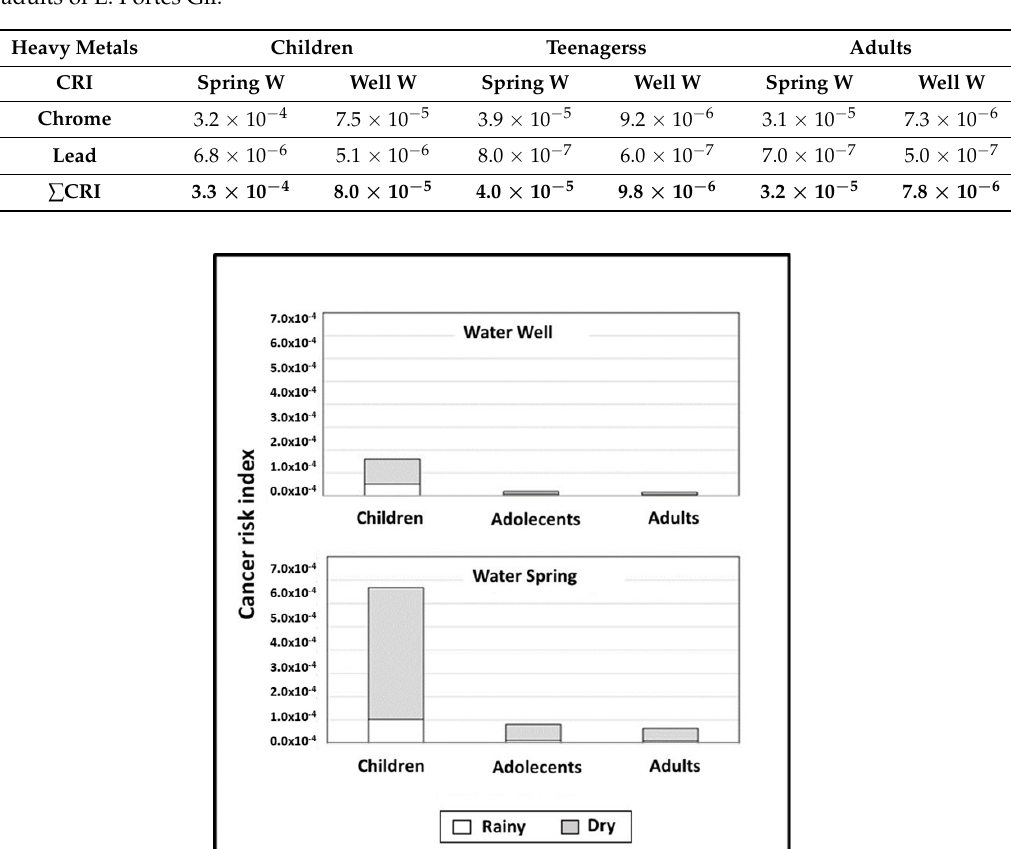
Table 5. Cancer risk index considering the individual and total effect of the potentially carcinogenic metals present at the spring W and the wells W., for the subpopulation of children, teenagers and adults of E. Portes Gil.